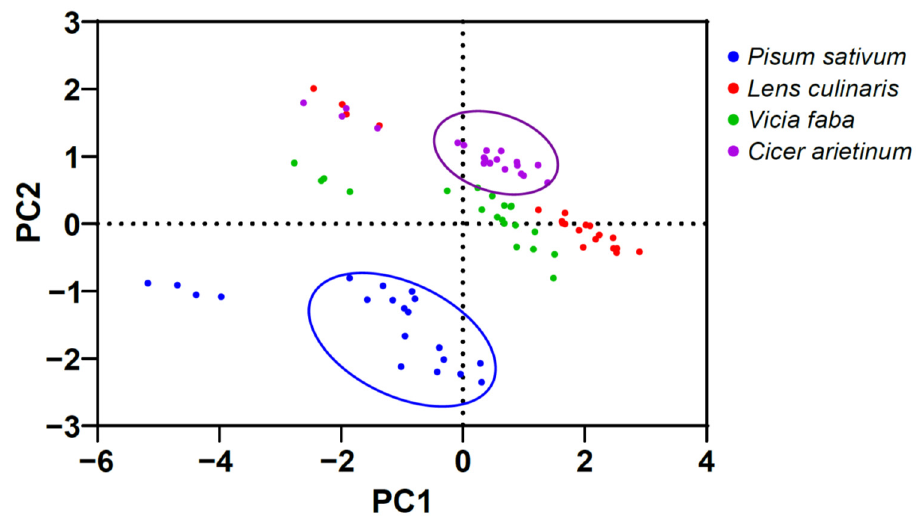
Figure 10. The principal component analysis plot (PCA) with photosynthetic parameters and pig- ments of plants in 0.5 L pots filled with commercial garden soil that were treated by watering 100 mL of 0.5 mg L − 1 NSAIDs every second day over a total of 20 days. PCA 1 and 2 explain 84.5% of the variation (61.9% and 22.6%, respectively). See Supplementary raw data in Table S1. From the PCA plot with all available data (Figure 11), the clustering of control plants could be seen compared with the treated plants. Even more, the Pisum sativum plants express high sensitivity to NSAIDs, but there is no clear pattern for the other species.